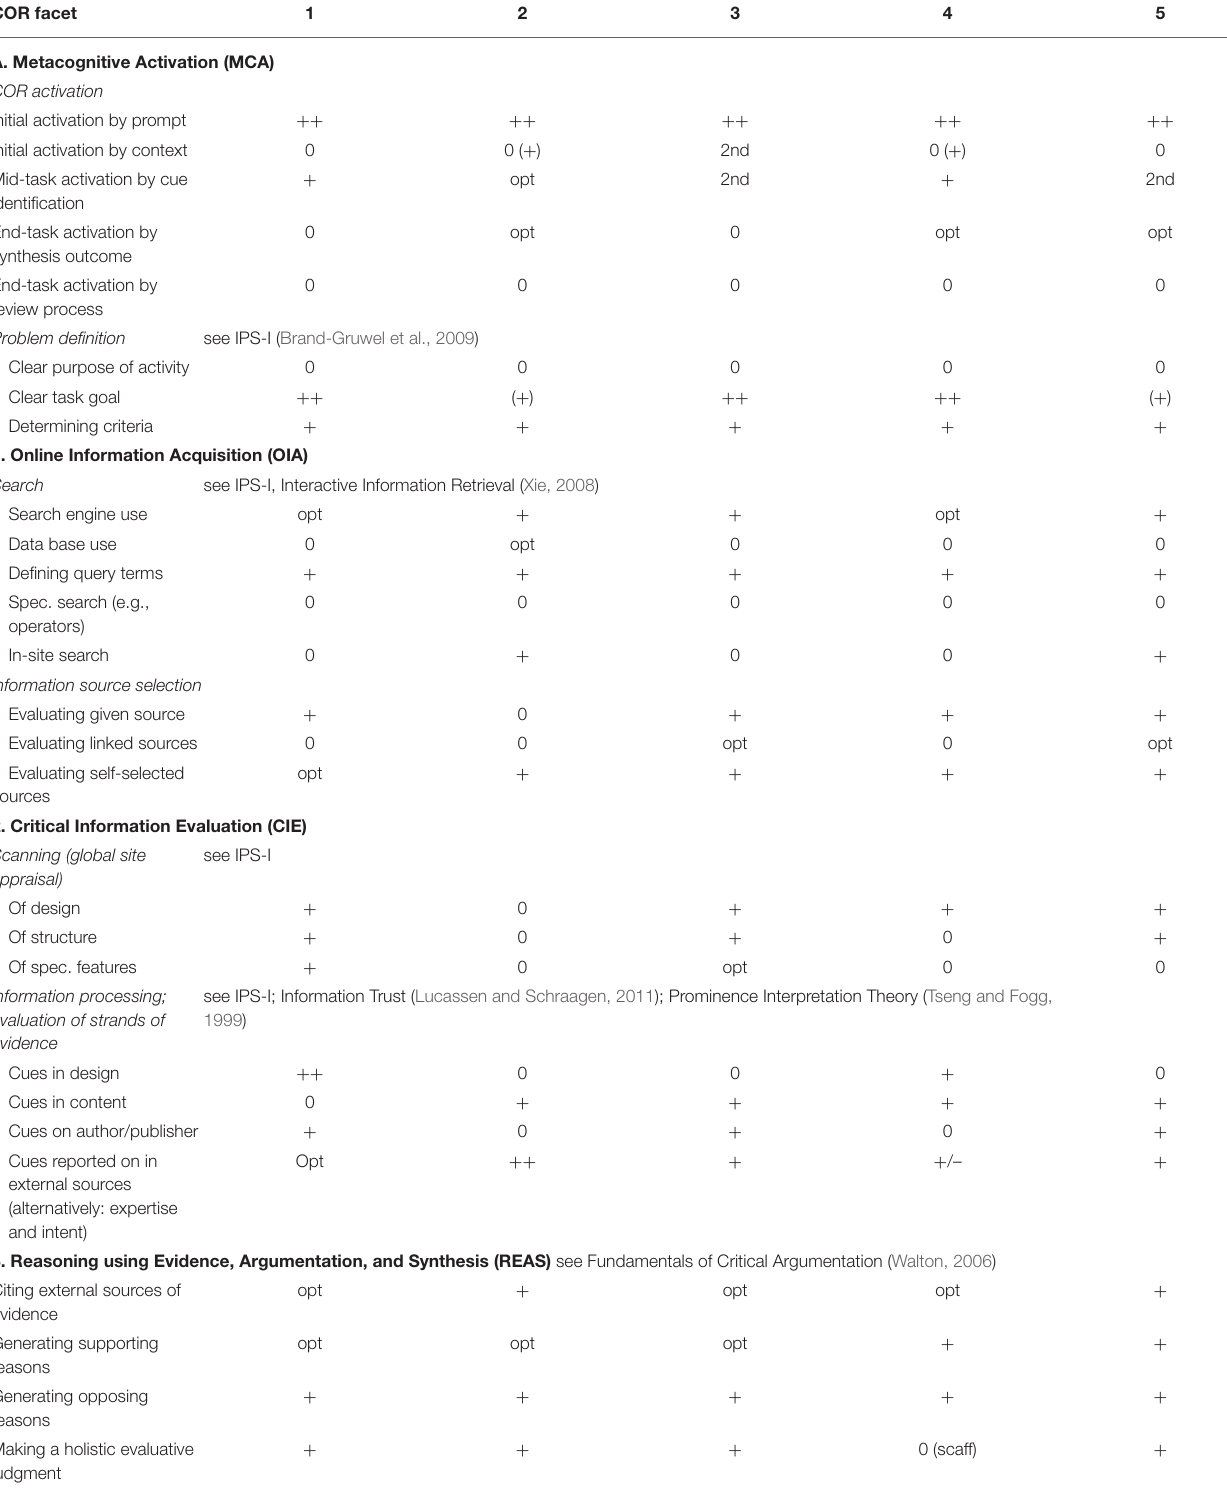
TABLE 4 | Content analysis of the CORA tasks as coverage of the major facets of the construct. COR facet 1 2